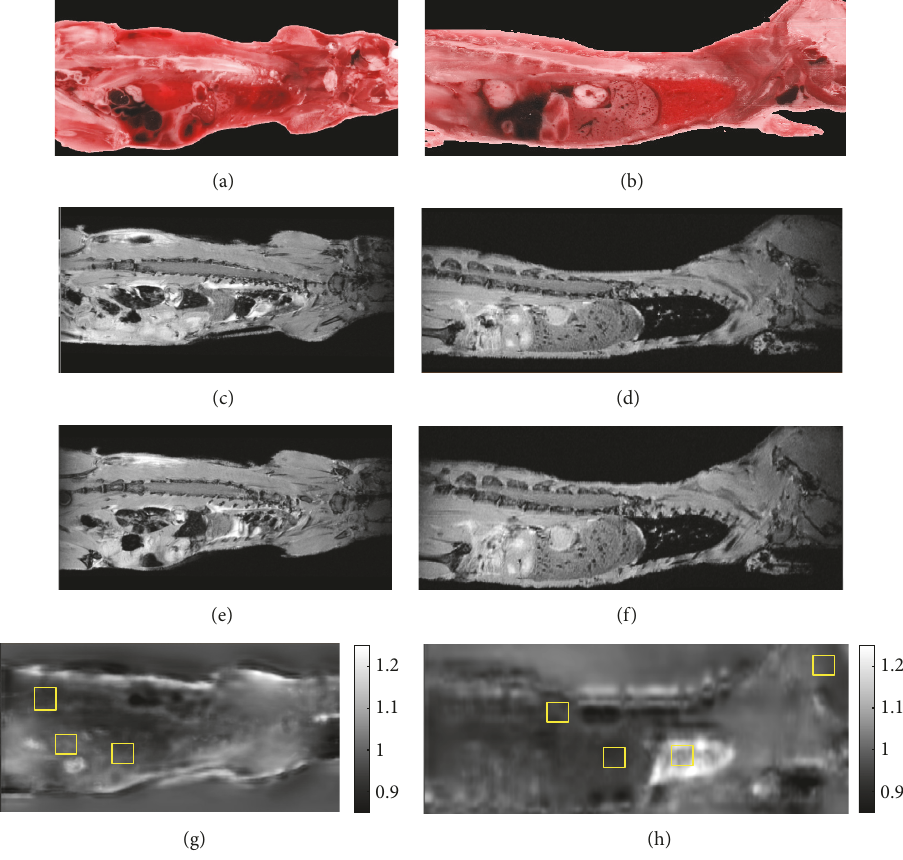
Figure 4: Evaluation of tissue expansion from spatial maps of the determinant of Jacobian. MR images are registered using rigid body (c, d) and affine plus nonrigid (e, f) to the reference color cryo-image volume ((a) coronal, (b) sagittal). The determinant of the Jacobian (g, h) can be interpreted as fractional volume change, with values < 1 and > 1 representing volume expansion and shrinkage, respectively. The color bar ranges from 0.85 to 1.25. In (g), within regions of interest (ROIs, yellow boxes) from left to right, values are muscle 0.93 ± 0.03, kidney 0.94 ± 0.02, and spleen 0.95 ± 0.02, where standard deviations come from voxelwise analysis in the ROIs. In the 𝑋𝑍 (h) view, ROIs from left to right are spinal cord 0.91 ± 0.03, liver 0.92 ± 0.01, lungs 1.18 ± 0.05, and brain 0.97 ± 0.01. A value of 0.92 in the liver corresponds to ∼ 8% expansion with freezing. The lung deflated and shrunk. Other animals showed similar expansion/shrinkage